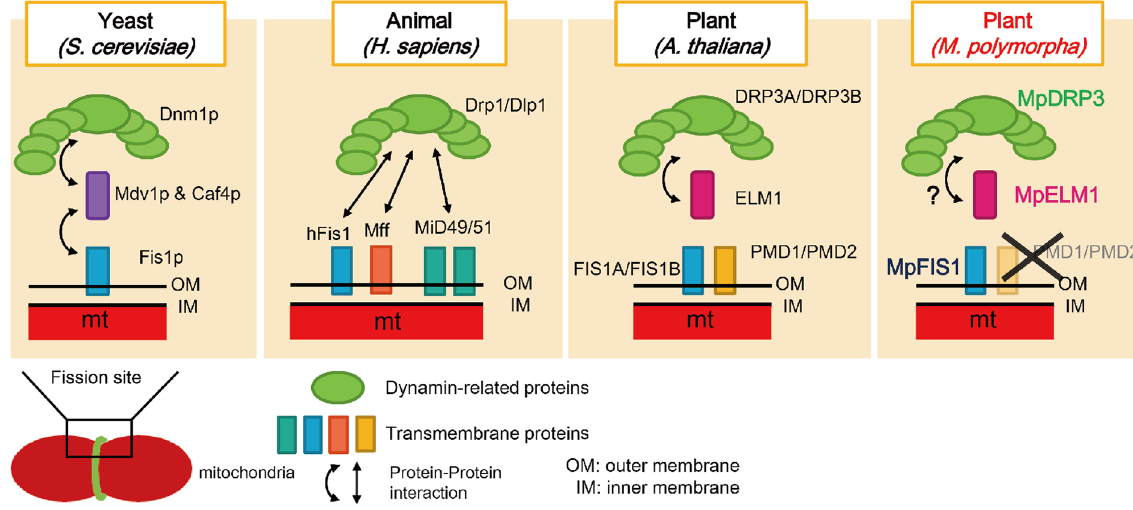
Figure 6. Comparison of mitochondrial fission factors in yeast, an animal and plants. These are current models of mitochondrial fission in S. cerevisiae , H. sapiens , A. thaliana and M. polymorpha